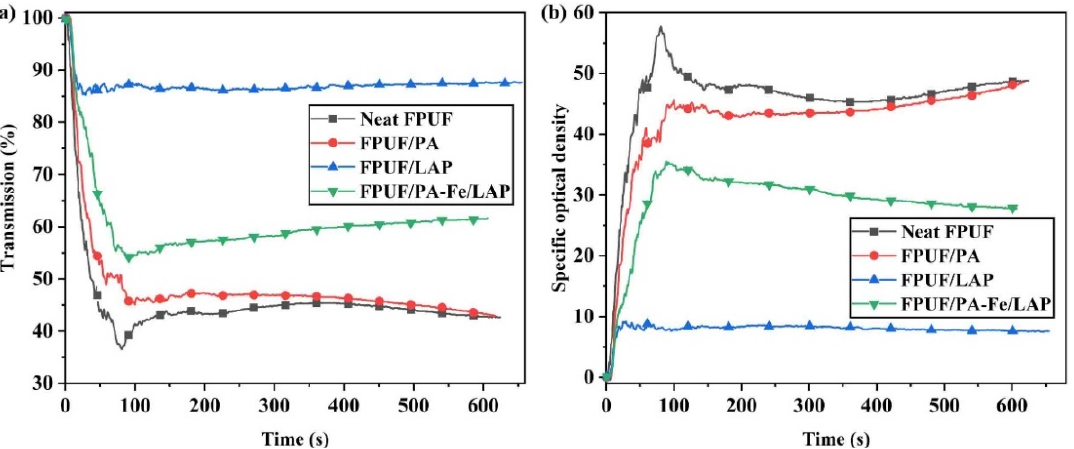
Figure 9. Light transmission ( a ) and specific optical density ( b ) curves of neat FPUF, FPUF/PA, FPUF/LAP, and FPUF/PA-Fe/LAP by SDT.